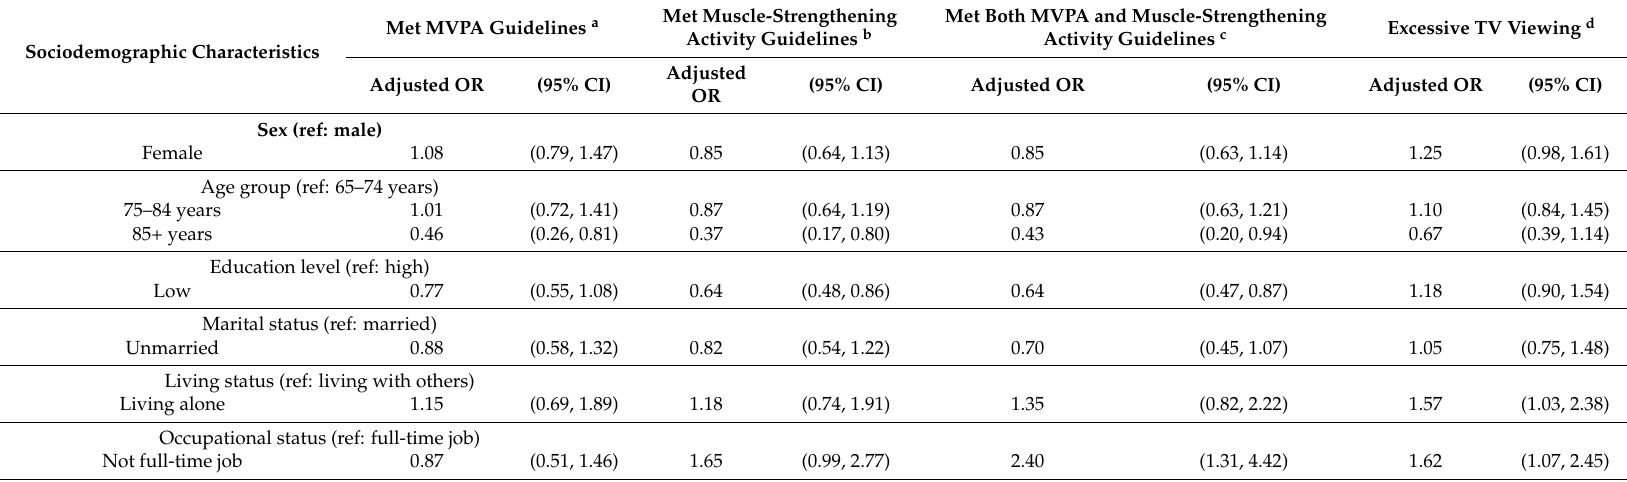
Table 2. Association between sociodemographic characteristics and meeting MVPA guidelines, meeting MS activity guidelines, meeting the combined MVPA–MS activity guidelines, and engaging in excessive TV